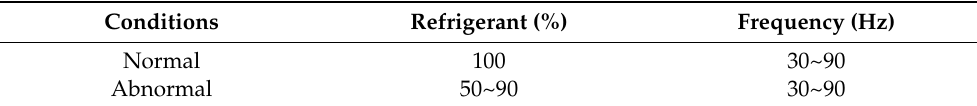
Table 3. Experiment variables in case